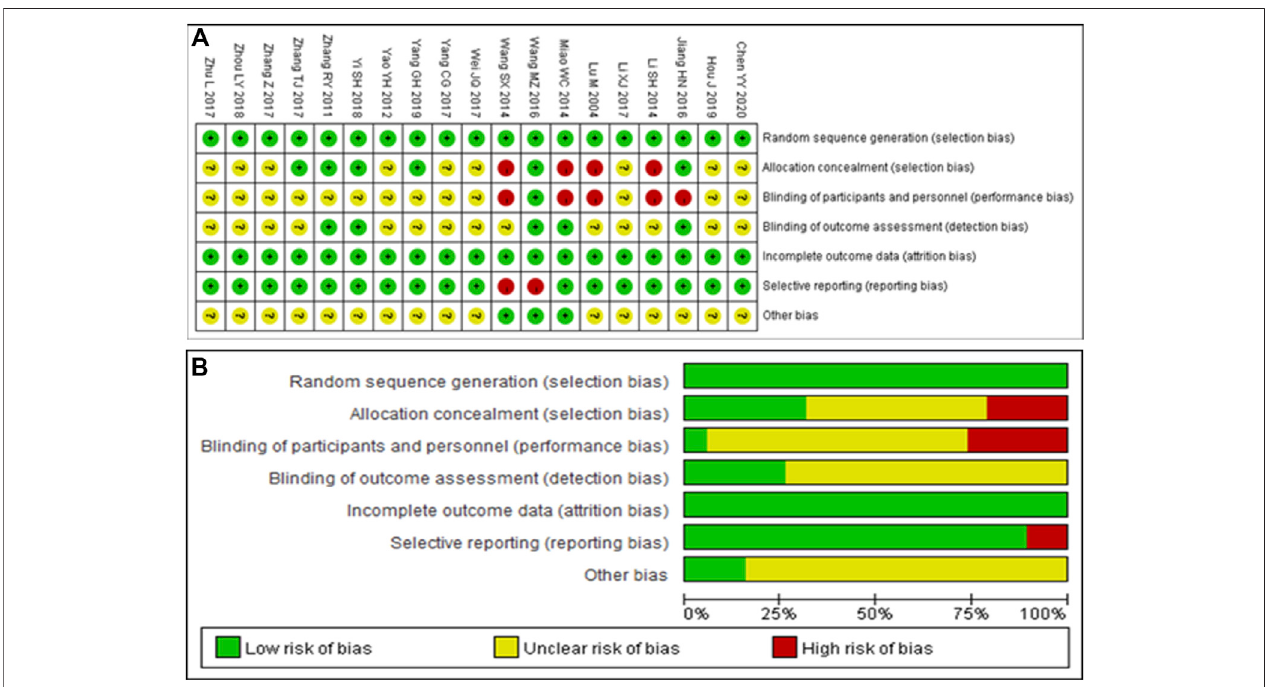
FIGURE2 | Quality assessment ofthe included randomized controlled trials. (A) Each riskofbias item is presented as thepercentages across all included studies. (B) Each risk of bias item for each included study. Green indicates a low risk of bias, yellow indicates an unclear risk of bias, and red indicates a high risk of bias.